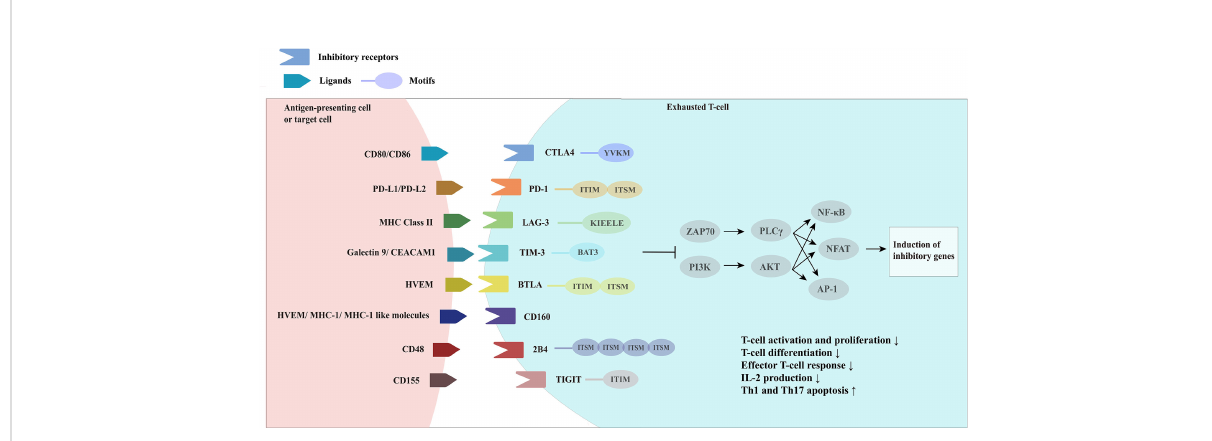
FIGURE 2 Overview of inhibitory receptors and related molecules in exhausted Tcells. CTLA4, cytotoxic T-lymphocyte associated protein four; PD-1, programmed cell death one; LAG-3, lymphocyte activation gene-3; MHC Class II, major histocompatibility complex class II; TIM-3, T-cell immunoglobin and mucin domain-3; CEACAM1, carcinoembryonic antigen-related cell adhesion molecule 1, BTLA, B-lymphocyte and Tlymphocyte attenuator; HVEM, herpes virus-entry mediator; 2B4, recombinant natural killer cell receptor 2B4; TIGIT, T-cell immunoreceptor with Ig and ITIM